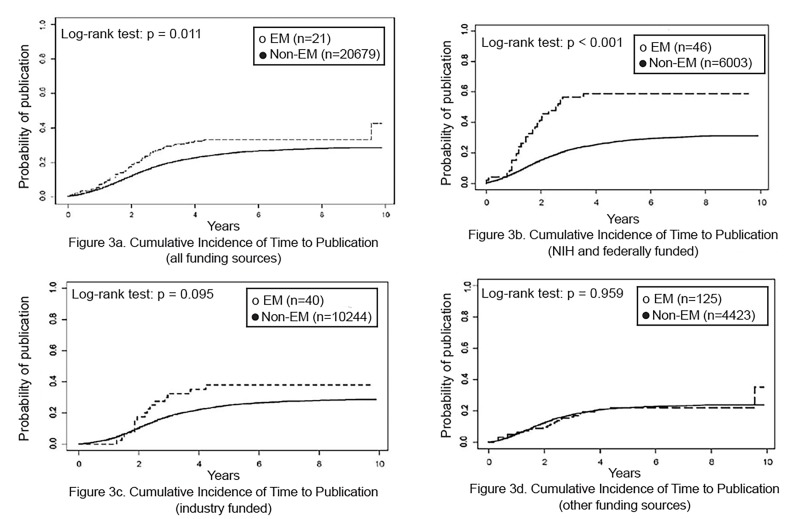
Cumulative incidence for time to publication overall and by funding source, emergency medicine (EM) and non-EM trials.NIH, National Institutes of Health.